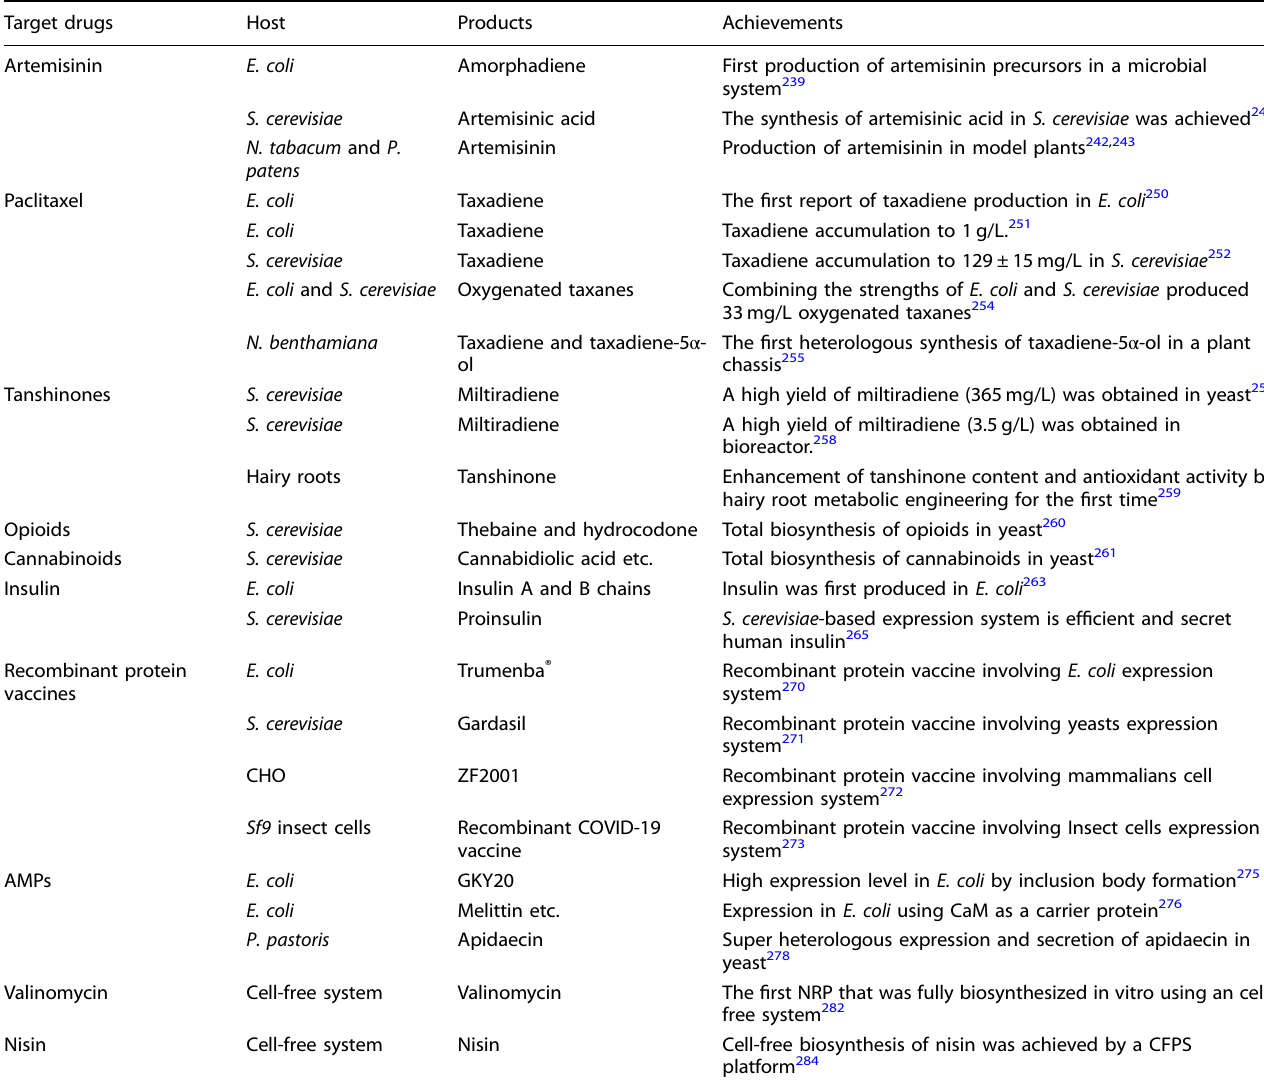
Table 4. Advances in the research of high-value natural drugs and precursor compounds Target drugs Host Products